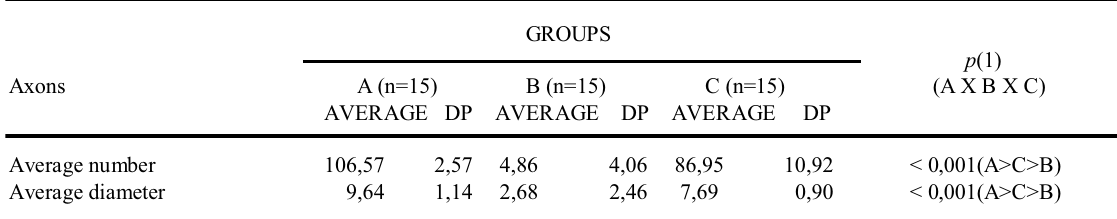
Note: if p < 0,05 – statistically significant difference. p (1) Kruskal Wallis and a posteriori Student Newman Keuls .